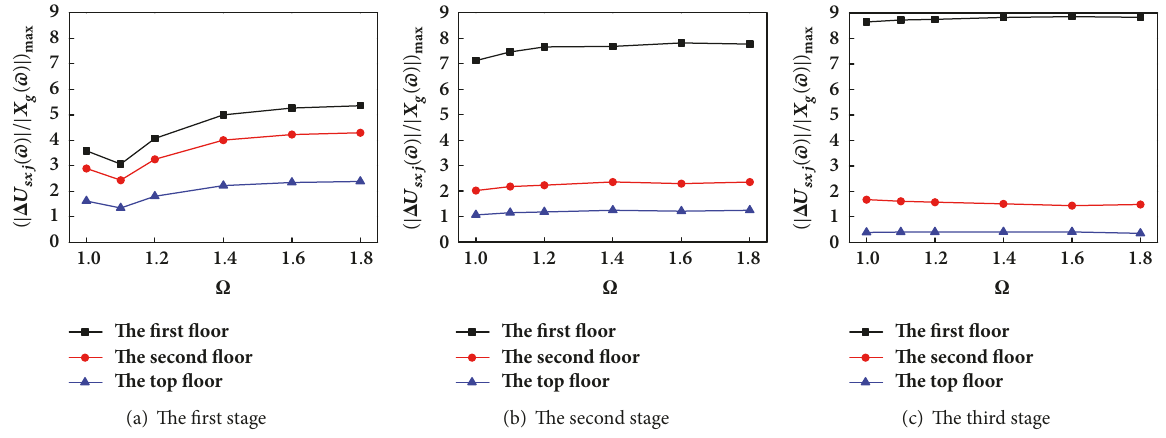
Figure 9: Interstory translation displacement in the 𝑥 direction under different Ω